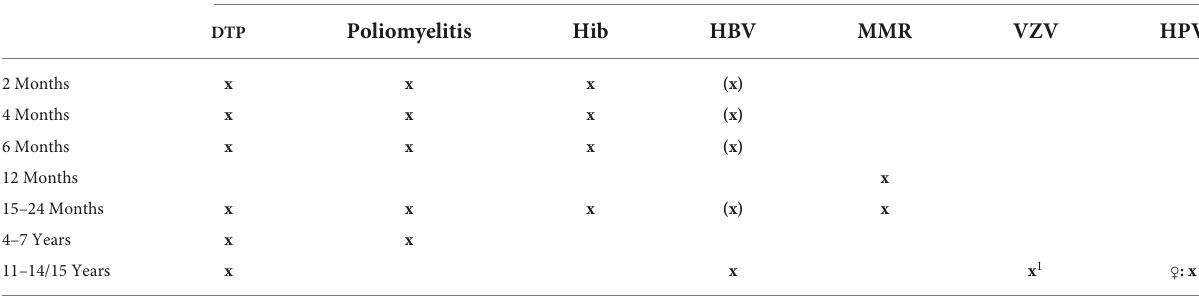
TABLE 1 Swiss national vaccination schedule